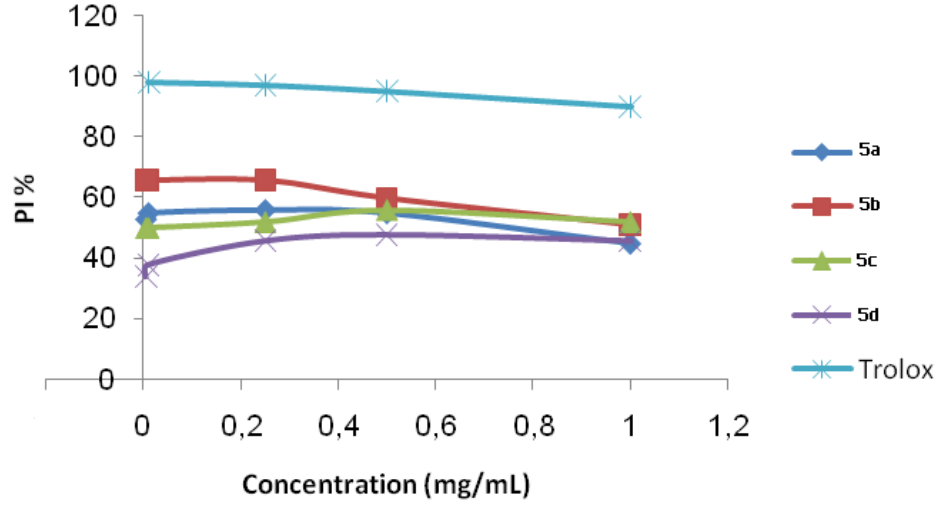
Figure 3. Scavenging ability on ABTS radical of compounds 5 .